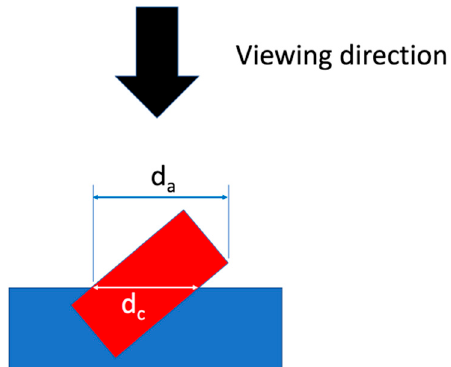
Figure 5. Schematic cross-section through a polished and etched surface showing the carbide dimension that would lead to a correct estimate of the carbide volume fraction (dc) and the corresponding apparent dimension (da) seen projected onto the plane of the scanned secondary electron (SE) image.